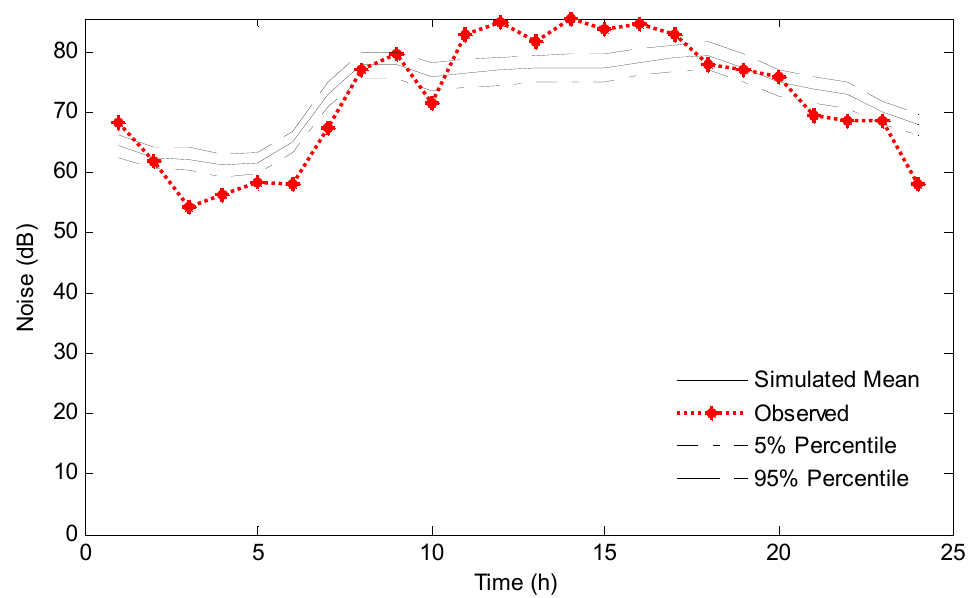
Figure 14. Variations of parameters ( a ) and ( b ) in Model (20) during the data assimilation process under scenario C.